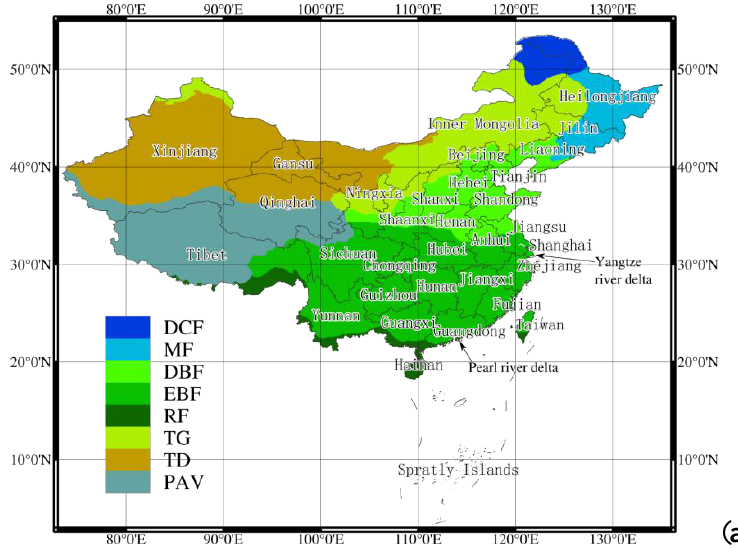
1. ( a ) Regional vegetation map of China. [55] DCF, cold temperate deciduous-coniferous forest; MF, temperate coniferous and broadleaf mixed forest; DBF, warm temperate deciduous broadleaf forest; EBF, subtropical evergreen broadleaf forest; RF, tropical monsoon and rain forest; TG, temperate grassland; TD, temperate desert; PAV, Qinghai-Tibet Plateau alpine vegetation; ( b ) Changing trend in mean annual temperature and ( c ) changing trend in mean annual